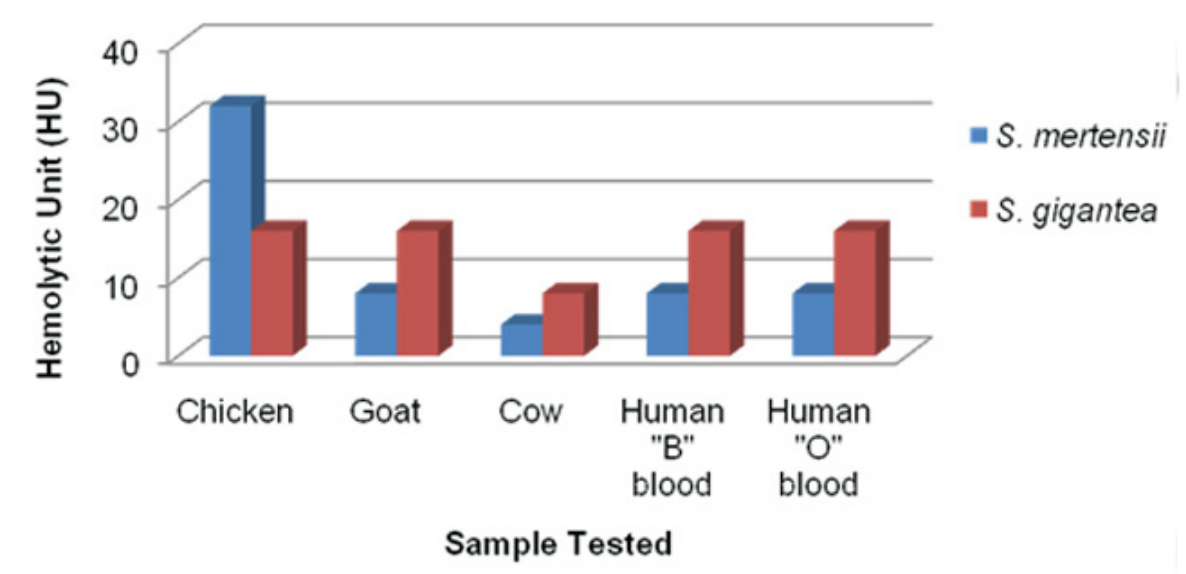
Figure 2. Hemolytic activity of the sea anemones S. mertensii and S. gigantea .